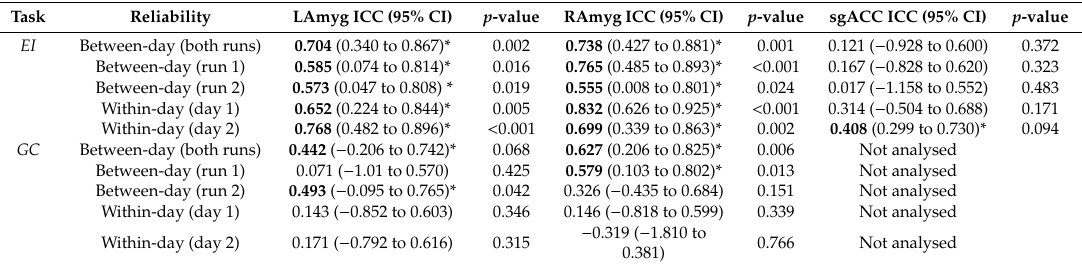
Table 2. Results from intraclass correlation coe ffi cient (ICC) analysis of PPI for the EI and GC tasks, extracted from the DMFC region of interest.